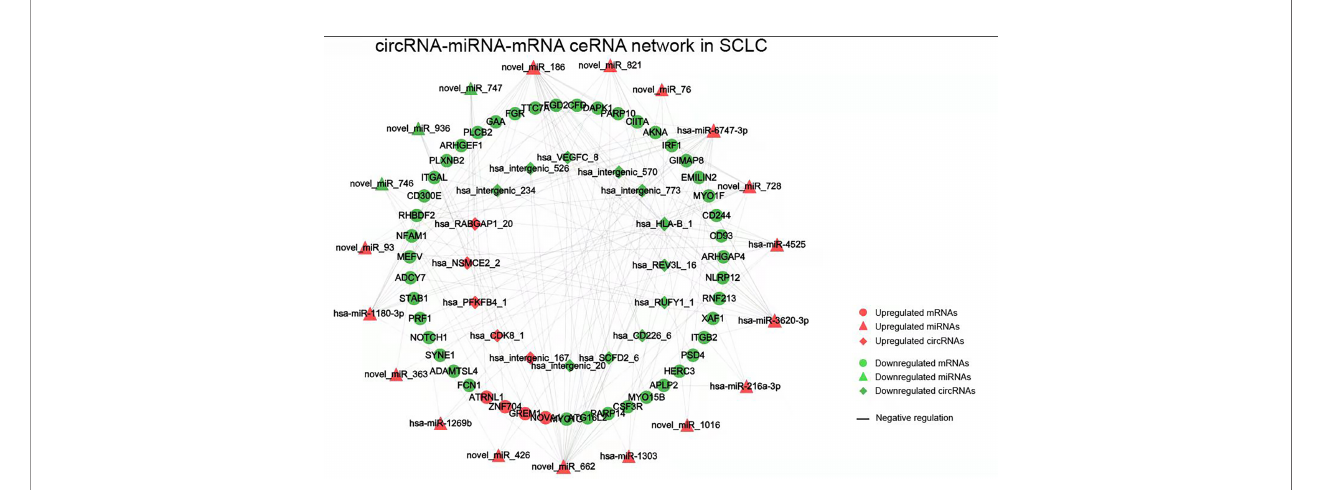
FIGURE 4 | The circRNA-miRNA-mRNA ceRNAs network in SCLC. circRNA, circular RNA; miRNA, microRNA; mRNA, messenger RNA; SCLC, small cell lung